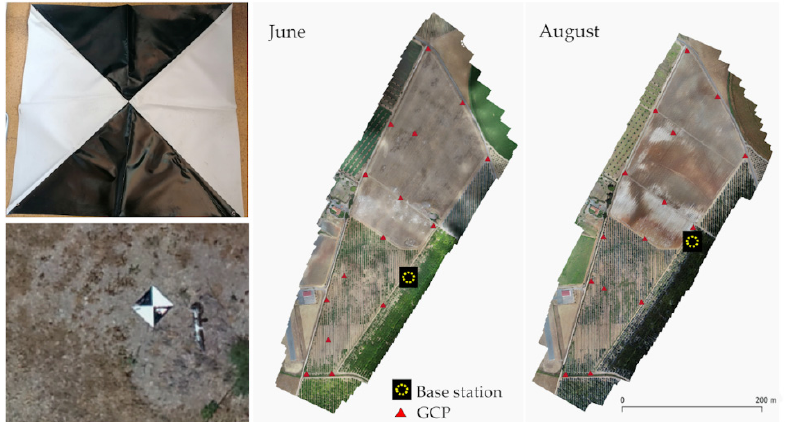
Figure 5. Artificial targets on the ground, spatial distribution of artificial GCPs on the ground for June and August, and location of the base station for each survey. June and August, and location of the base station for each